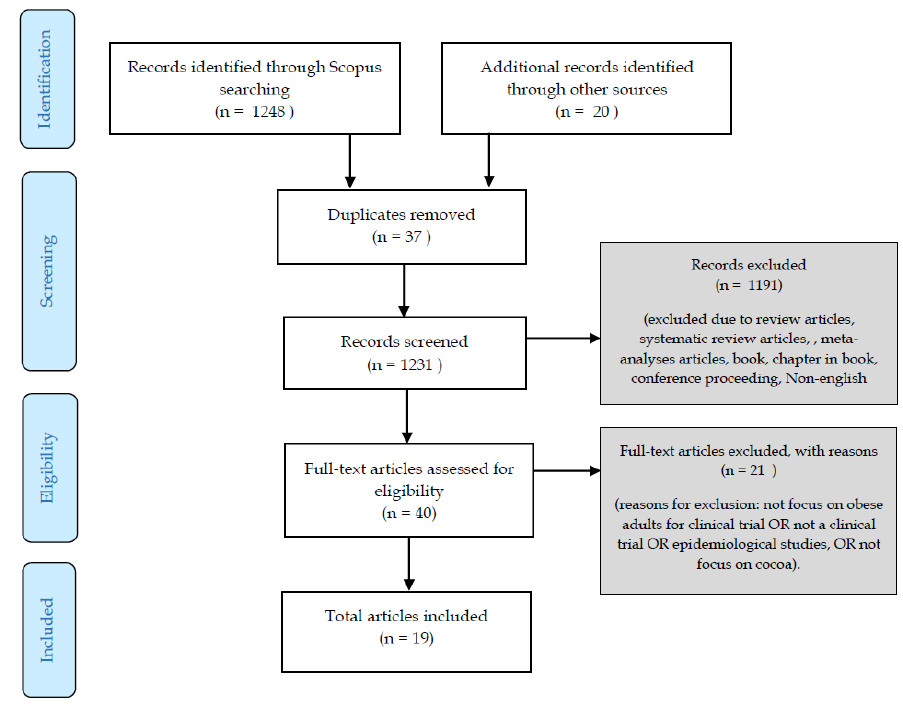
Figure 1. Summary of the selection of publications.